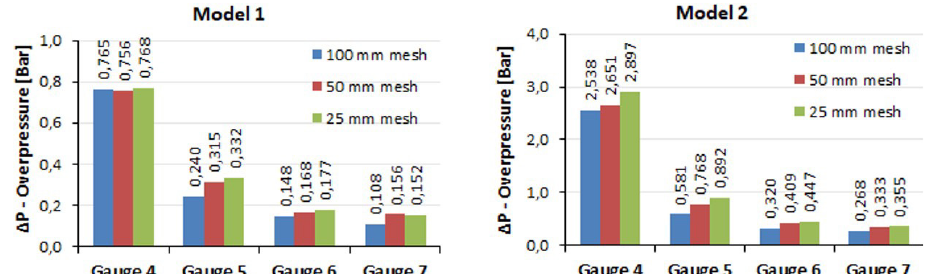
Figure 13. Overpressure peaks in gauges 4 to 7 of models 1 and 2 (explosions of aboveground tanks with volumes of 0,5 m 3 and 2,0 m 3 ).